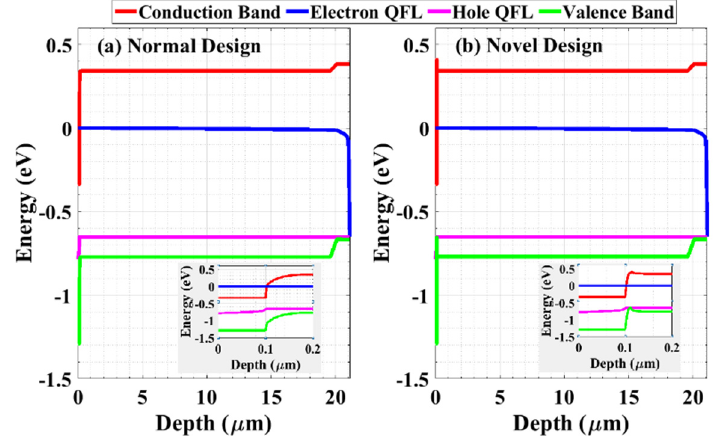
Figure 3. Optoelectronic characteristics of both the novel and normal designs under illumination ( a ) EQE and ( b ) J-V characteristics.